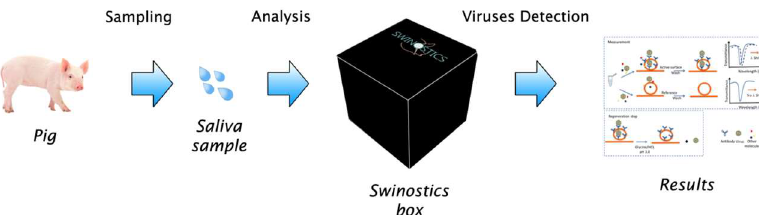
Figure 1. Schematic representation of the target application of the SWINOSTICS (swine diseases field diagnostics toolbox) device. Three main steps are needed: sampling, analysis and virus detection.